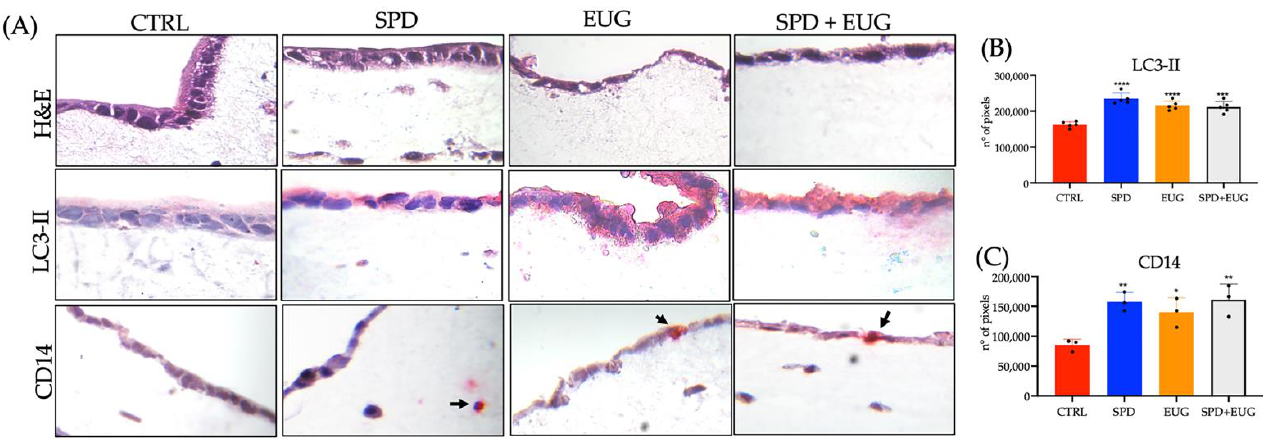
Figure 6. ( A ) Hematoxylin and eosin (H&E), LC3-II staining and CD14 staining of U937 monocytes in 3D intestinal equivalents (Caco-2 /U937/L929 co-cultures) exposed to 0.3 mM spermidine (SPD) and 0.2 mM eugenol (EUG) and in combination (0.3 mM SP + 0.2 mM EUG) compared to the untreated control. Arrows indicate the presence of monocytes (CD14 positive cells). The magnification was × 40. ( B ) Quantification of the LC3-II stained Caco-2 cells and ( C ) CD14 stained U937 cells. The number of stars *, **, *** and **** represents significant differences between treatments as determined by one-way ANOVA at the 99% confidence level ( p < 0.01). The black dots indicate the positioning of the individual replicates within the bar for each